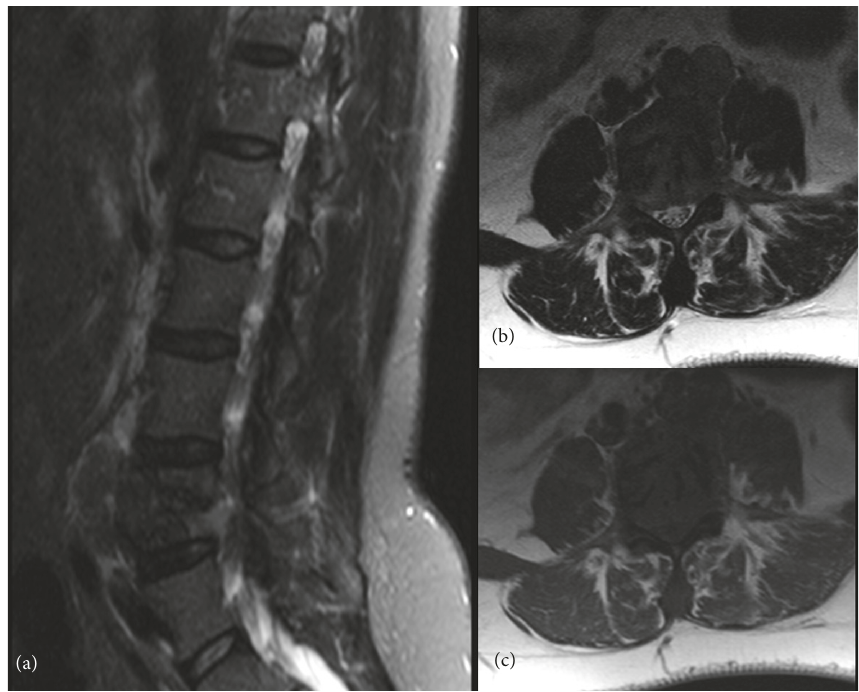
Figure 1: MR of the lumbar spine. (a) T2-weighted sagittal Spectral Attenuated Inversion Recovery (SPAIR) image. (b) T1-weighted axial image. (c) T2-weighted axial image. There is a T1-hypointense, T2-heterogeneous soft tissue mass occupying and destroying a large part of L4, causing nerve root compression.